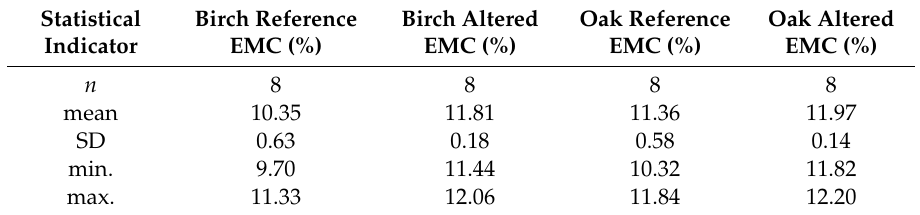
Table 3. Overview of the altered equilibrium moisture content (EMC) of the reference test set after storage in salt solution for birch and oak wood investigated at standard climate conditions